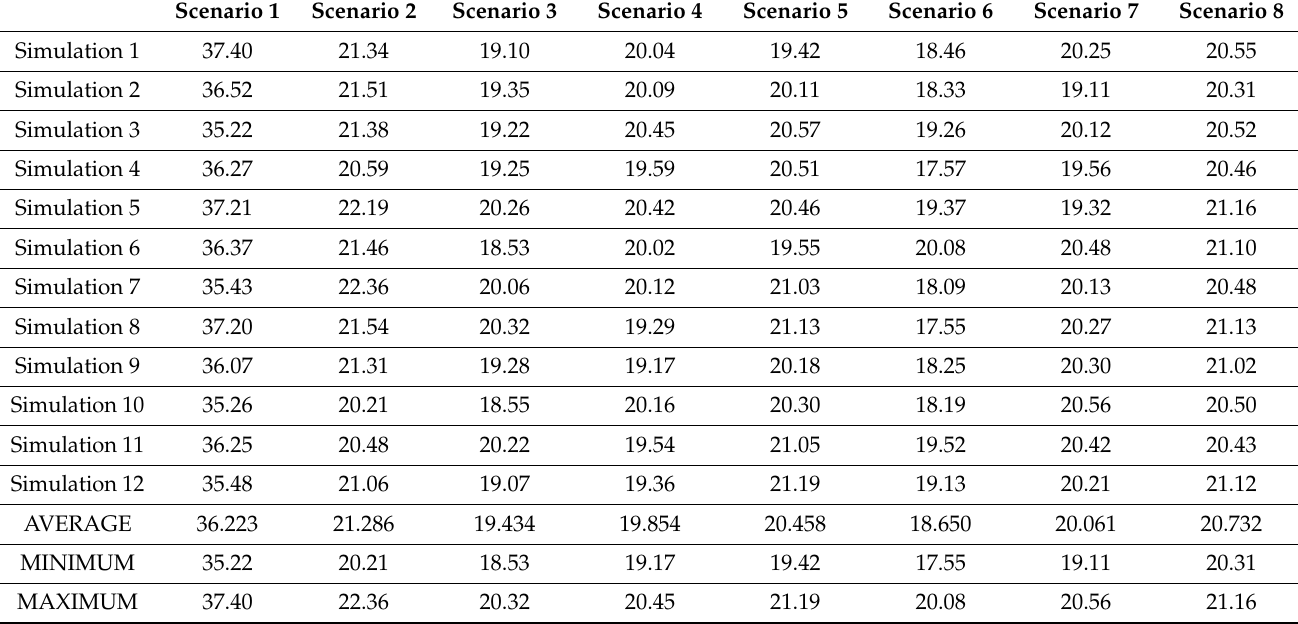
Table 3. Summary of evacuation times for 12 simulations done for 8 different scenarios.